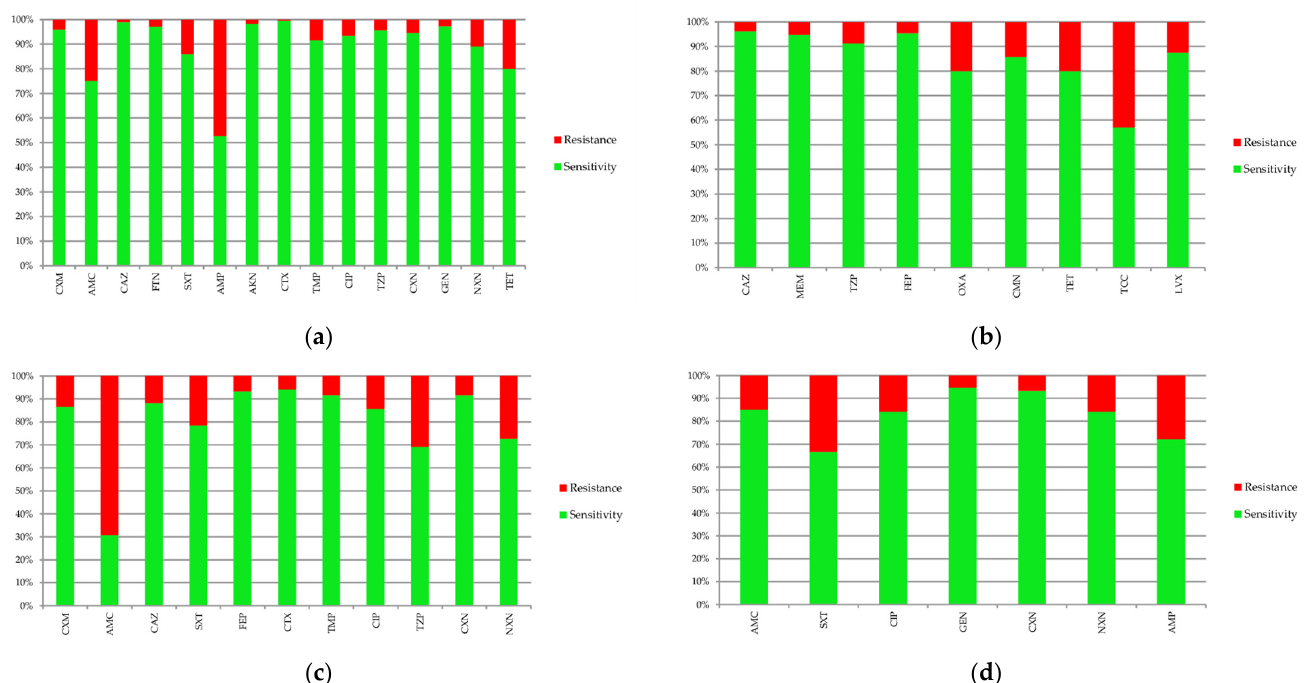
Figure 8. Sensitivity and resistance of bacteria to antibiotics: ( a ) Escherichia coli ; ( b ) Pseudomonas aeruginosa ; ( c ) Klebsiella pneumonia ; ( d ) Proteus mirabilis . AKN—amikacin, AMC—amoxicillin with clavulanic acid, AMP—ampicillin,